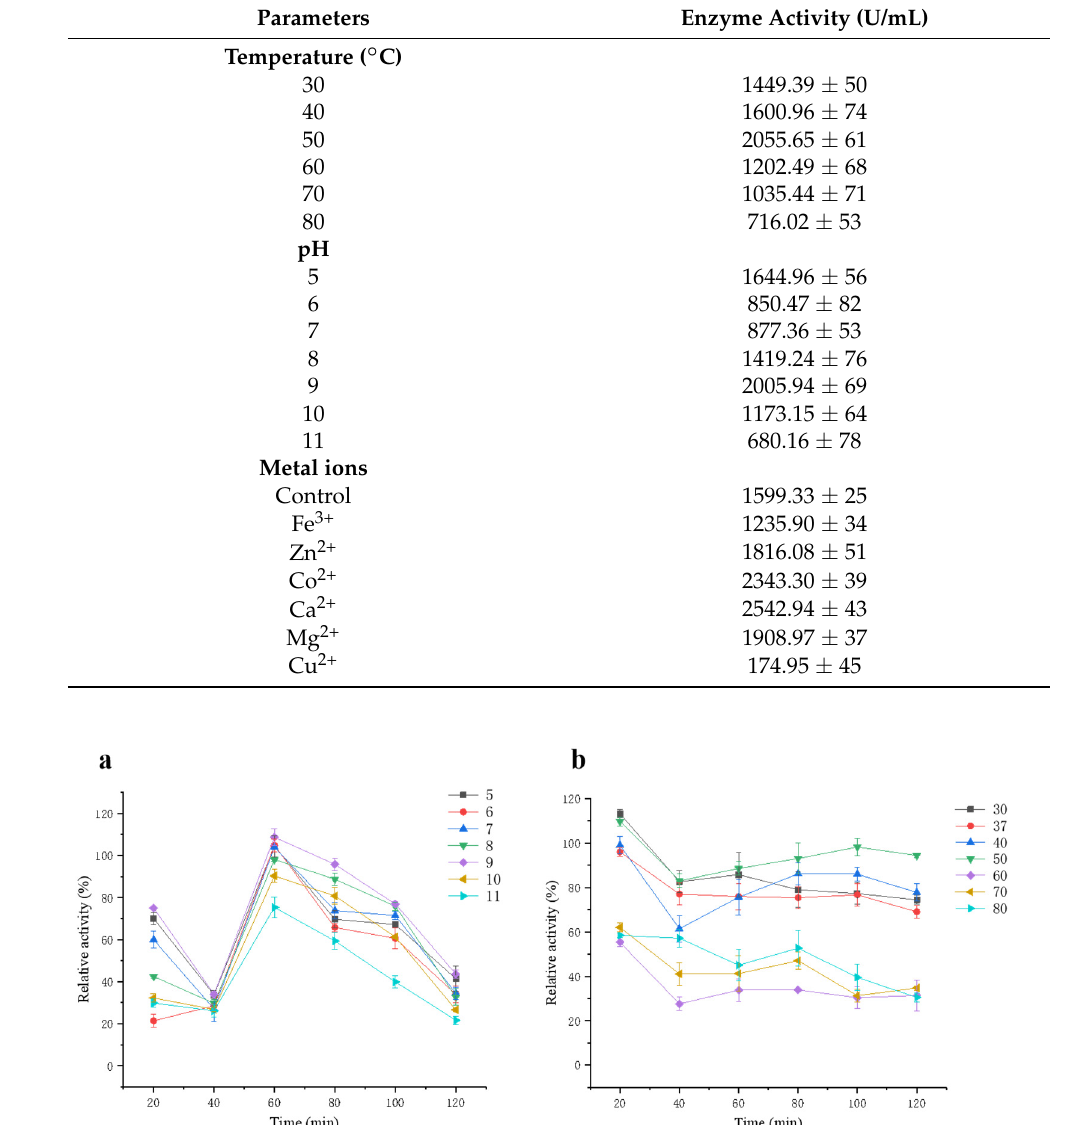
Table 3. Effect of temperature, pH, and metal ions on recombination collagenase activity.